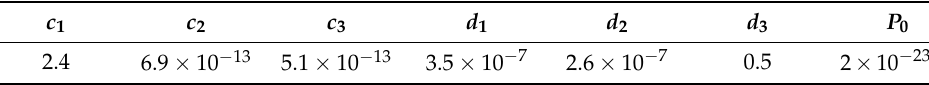
Table 1. Parameters used in numerical